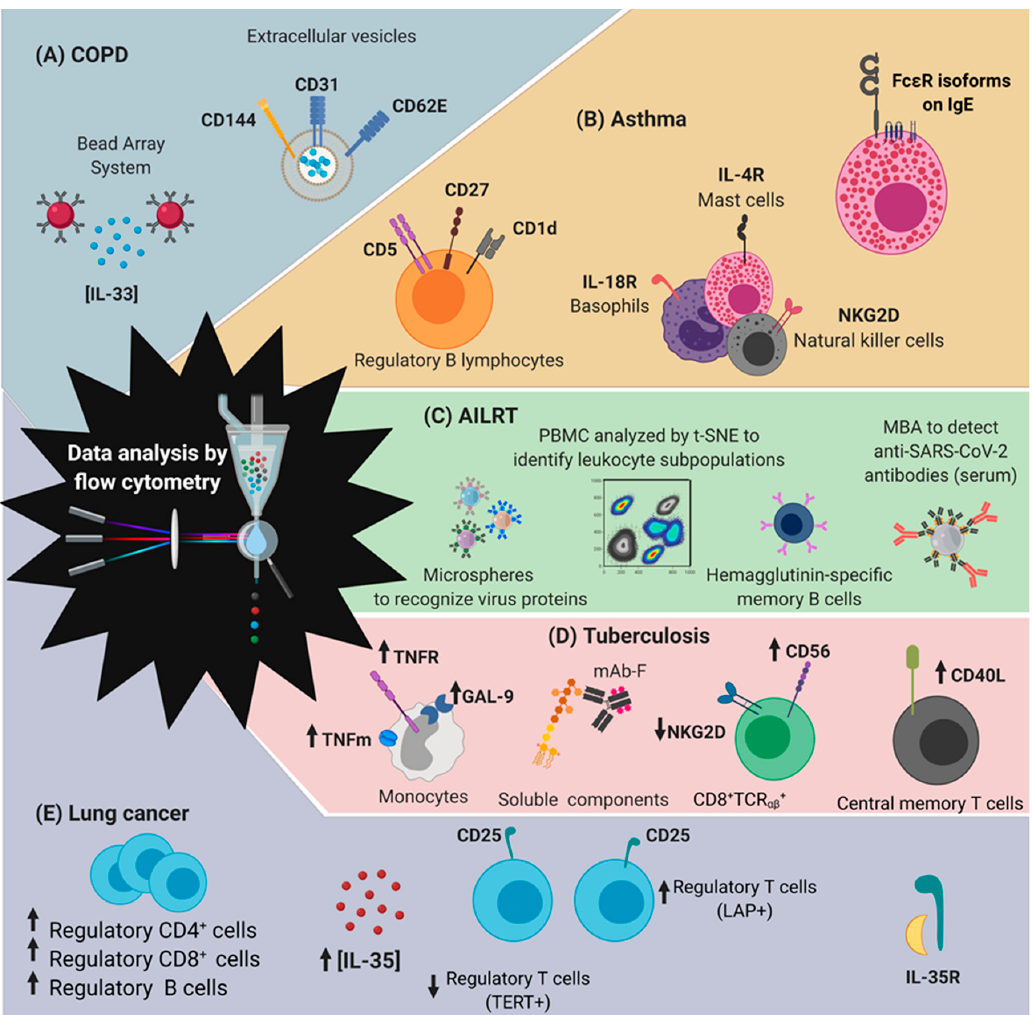
Figure 4. Developments in the diagnosis of respiratory diseases obtained by flow cytometry